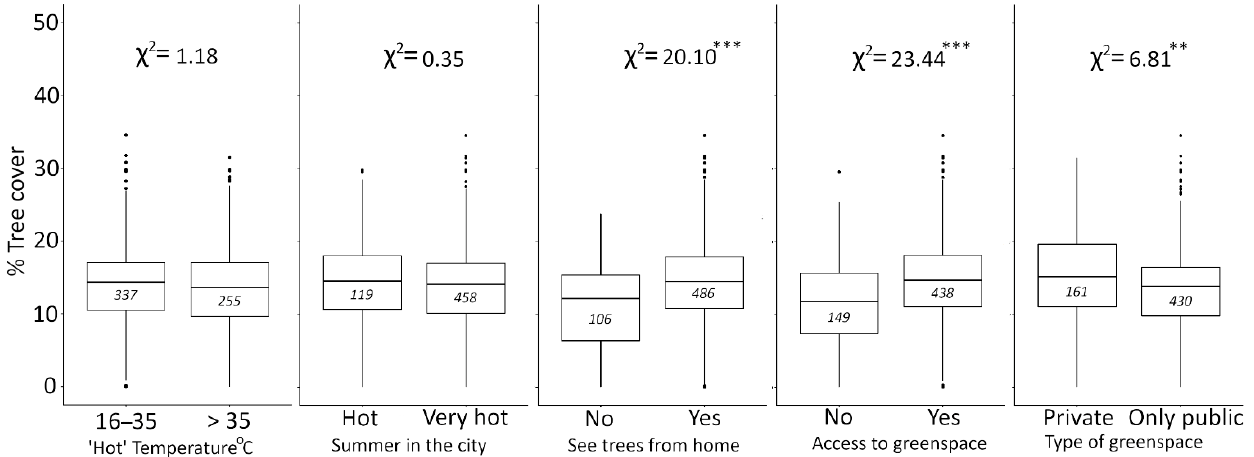
Figure 1. Donut charts representing response proportions to survey questions ( n = 592).